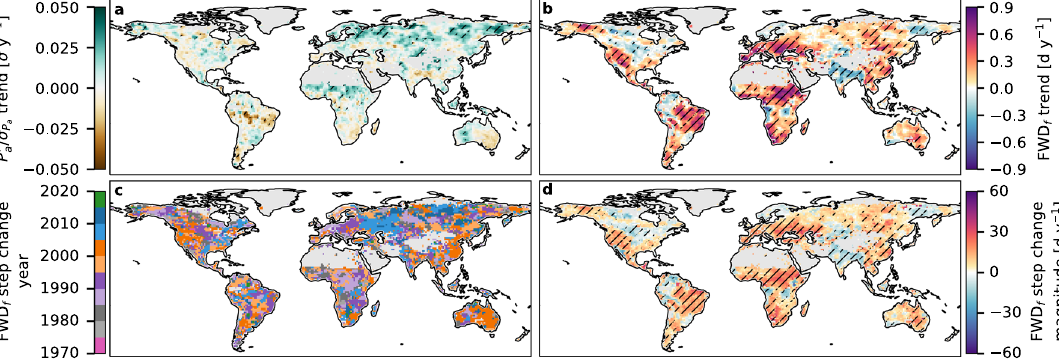
Fig. 4 Fire weather and precipitation trends and change points 1970 – 2020. a Theil-Sen slope for normalised annual antecedent (dashes indicate anomalies). b As in a but for annual numbers of fi re weather days, FWD f . Hatching in ( a ) and precipitation anomalies, P 0 = σ P a ( b ) indicates a statistically signi fi cant result for the Mann-Kendall test for monotonic trends. c Pettitt test year of potential step change in annual numbers of fi re weather days FWD f . d Pettitt test step change magnitude for FWD f . Hatching in ( d ) indicates statistical signi fi cance for the Pettitt